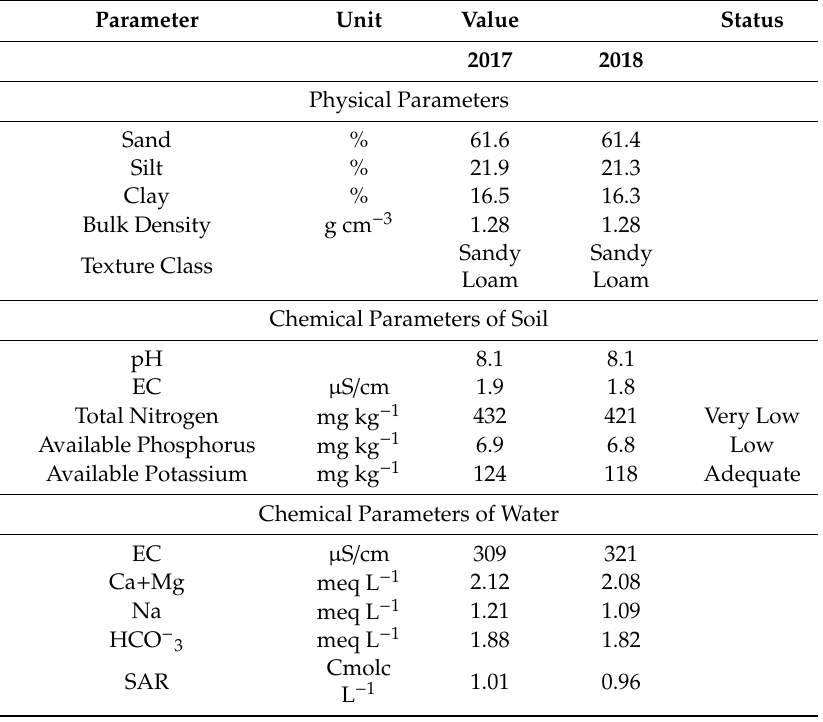
Table 1. Physiochemical properties of soil and irrigation water used for the experiment.